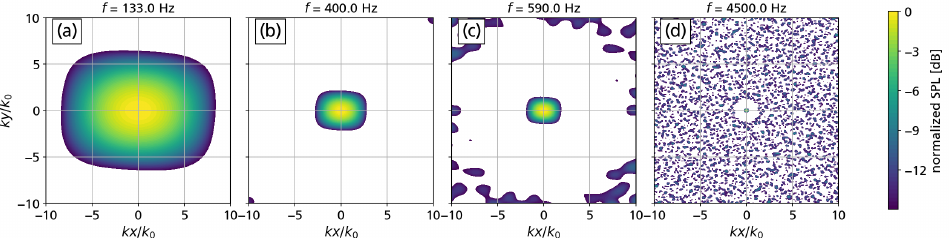
Figure 5. ( a – d ) Point spread function (PSF) of the array in wavenumber space at selected